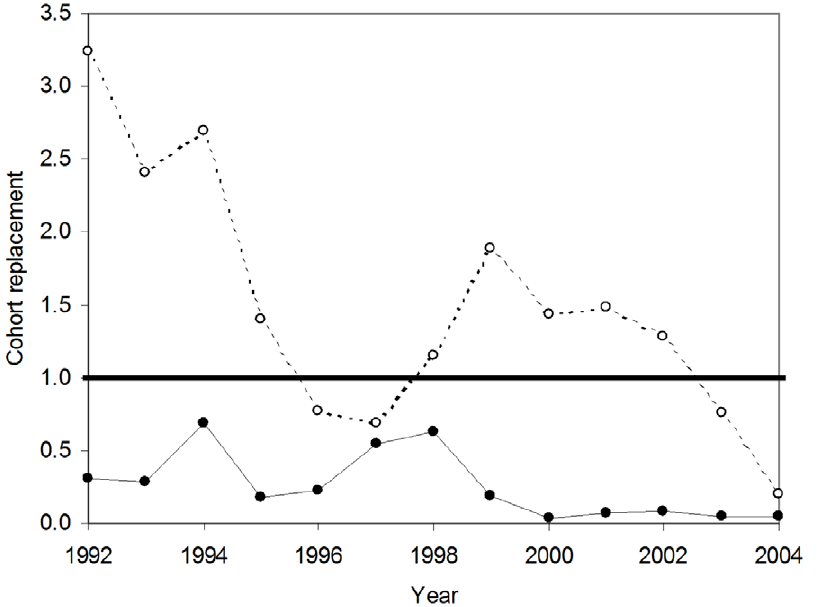
Figure 4. Population growth rates. Population growth estimates of Chinook salmon ( Oncorhynchus tshawytscha ) on the Mokelumne River watershed from cohort reconstruction. Apparent growth rate estimates (open circles) show several years where cohort replacement values exceed 1 (solid line). Natural population growth rates (filled circles) remove the influence of immigration from hatchery fish. These results suggest that in-river populations are being supported by hatchery sources.